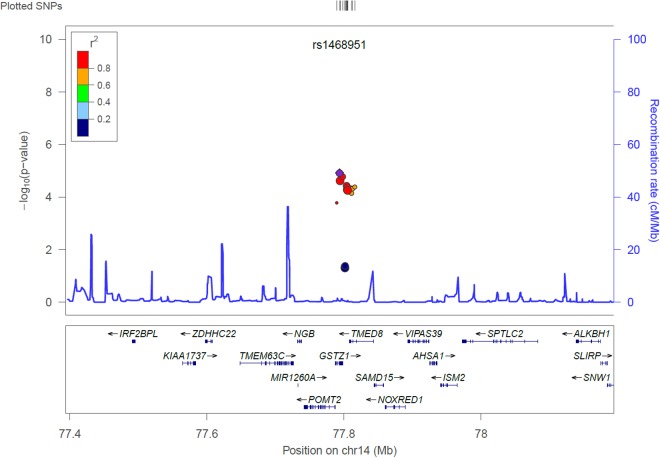
Locus-specific association map generated from genotyped SNPs in the chromosome 14, centered at rs1468951 for cognitive functioning.Note: Vertical axis is the—log10 of the p-value, the horizontal axis is the chromosomal position. Each dot represents a SNP tested for association with cognitive functioning. Linkage disequilibrium (LD) between the most significant SNP, listed at the top of the plot, and the other SNPs in the plot is shown by the r2 legend. Locus zoom software was used to prepare this figure.[36]